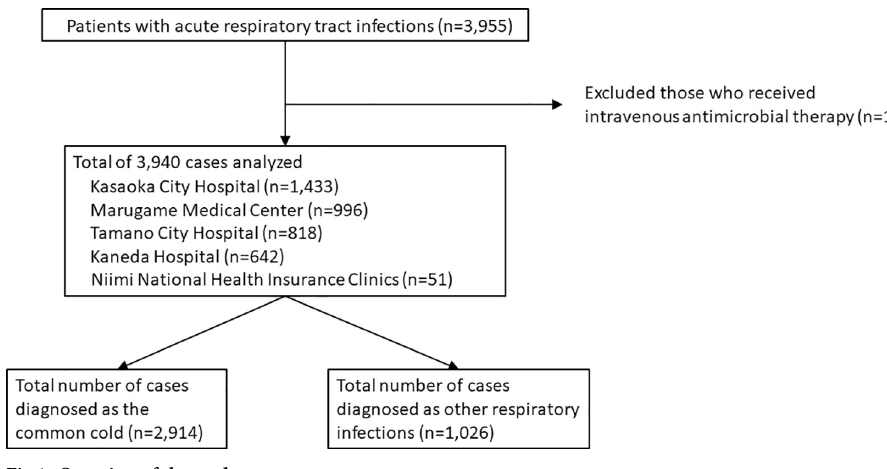
Fig 1. Overview of the